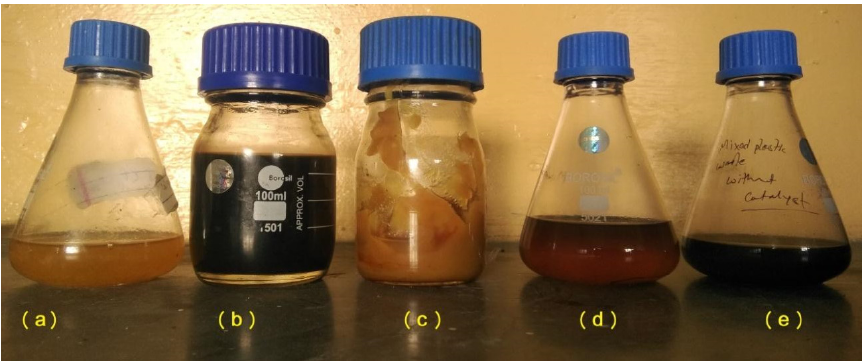
Figure 4. Different alternate fuels produced from ( a ) PP ( b ) LDPE ( c ) HDPE ( d ) Mixed virgin plastic ( e ) Domestic plastic waste (all products shown are produced at optimum temperature condition).